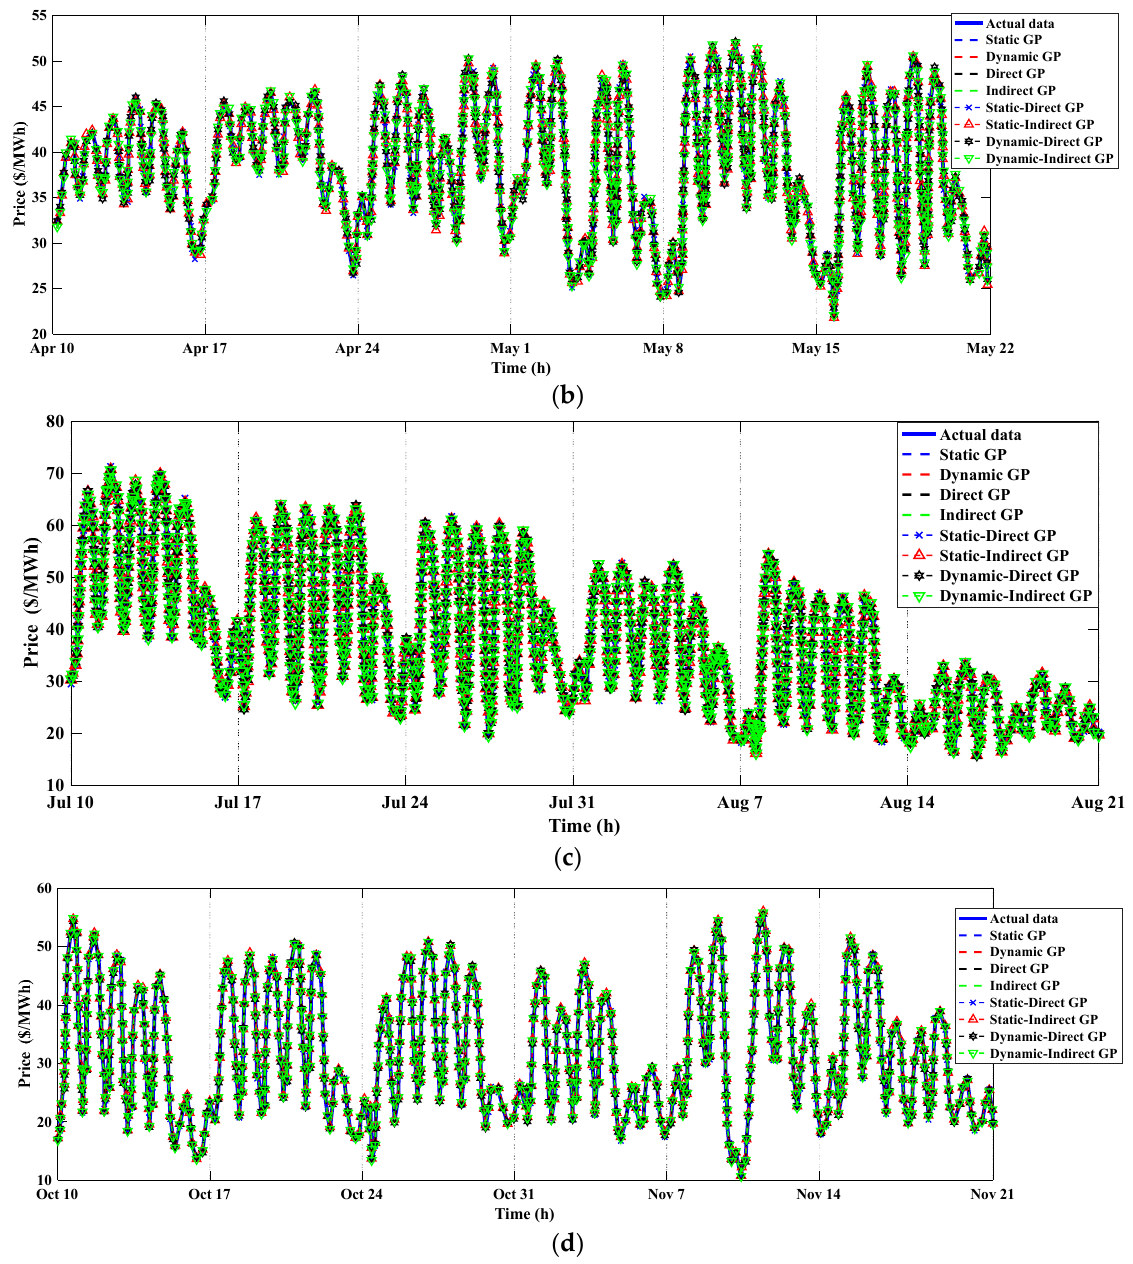
Figure 5. The forecasting of the main component of training data of EP using various models for the electricity market of Spain: ( a ) winter, ( b ) spring, ( c ) summer, ( d )